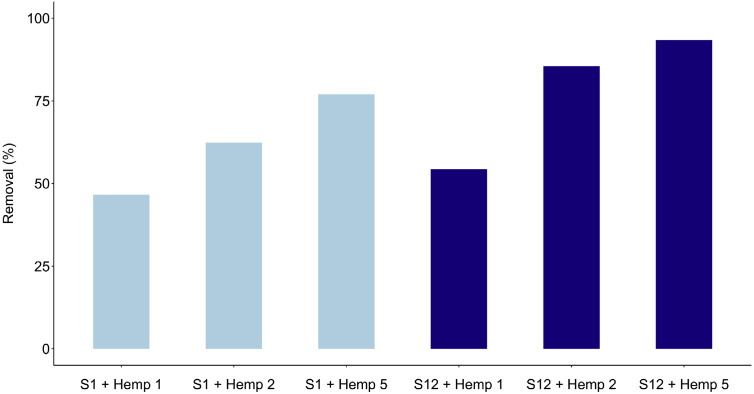
Effect of hemp dose on difenoconazole removal (in %) at two fungicide concentrations, 1.2 mg/L for solution S1 and 12 mg/L for solution S12 (conditions: batch experiments; 0.35, 0.7 and 1.75 g for Hemp 1, Hemp 2 and Hemp 5, respectively; volume 50 mL; contact time = 15 min; agitation speed = 250 rpm; temperature = 25 °C; n = 3).